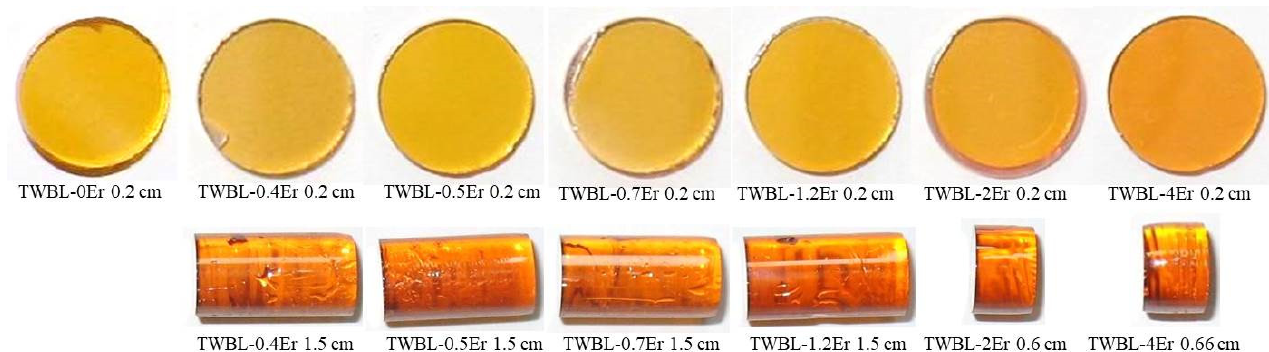
Figure 1. Photographs of the polished discs (tablets) and cylinders made of TeO 2 -WO 3 -Bi 2 O 3 -(4-x)La 2 O 3 -xEr 2 O 3 glasses.